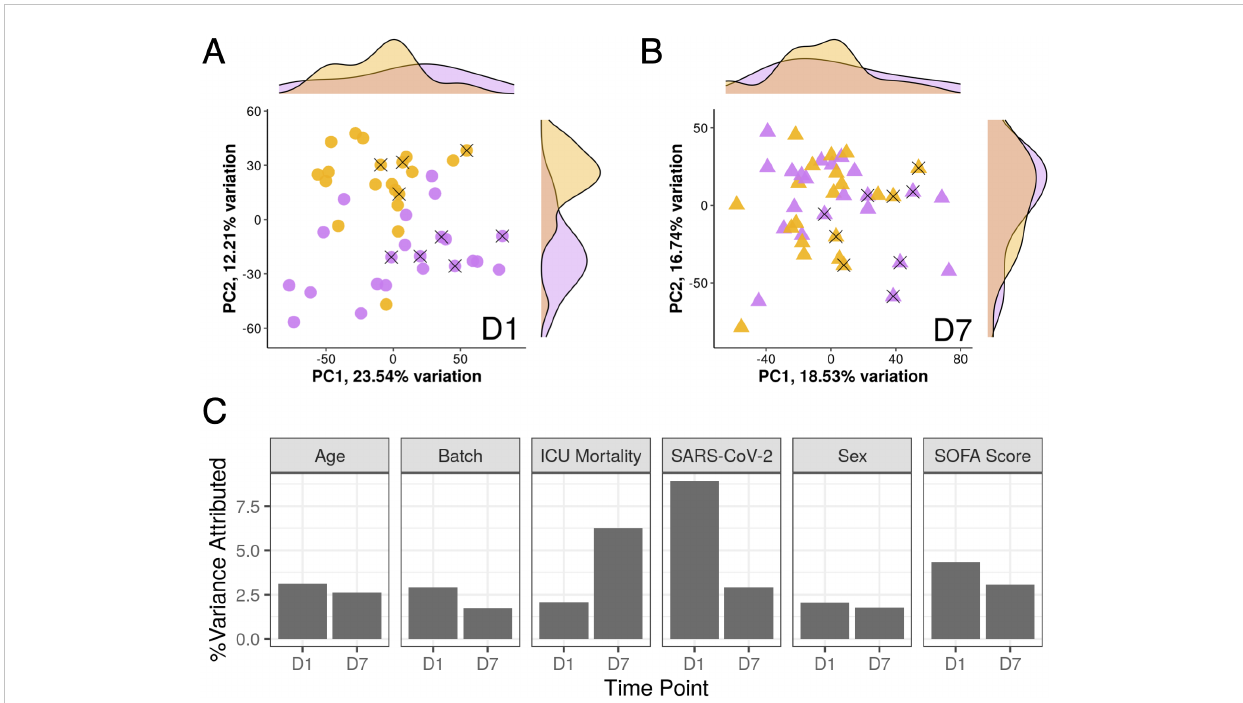
FIGURE 2 SARS-CoV-2 infection strongly in fl uenced gene expression only at D1. Shown is a principal component analysis of analyzed ICU patients. The fi rst two principal components were plotted and labelled based on COVID-19 status (yellow = SARS-CoV-2 positive, purple = SARS-CoV-2 negative) from D1 samples (A) and D7 samples (B) . X ’ s indicate patients who died in hospital. Density plots on the sides show the distribution of samples by COVID-19 status across the two principal components. (C) Percent variance of gene expression attributed to different metadata variables at D1 and D7. Notably, the percent variance attributed to SARS-COV-2 positivity strongly decreased from D1 to D7. In contrast, variance at D7 was more attributed to ICU